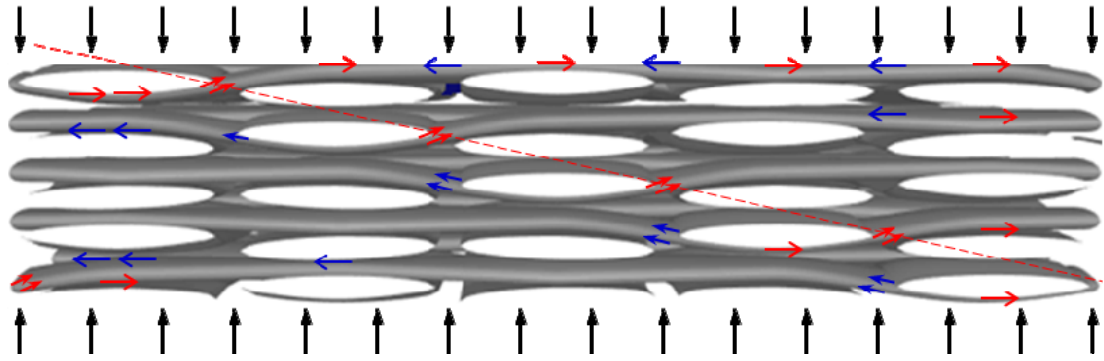
Table 4. Mean absolute percentage errors ( MAPE ) of predicted mechanical properties of thermo- plastic composites.